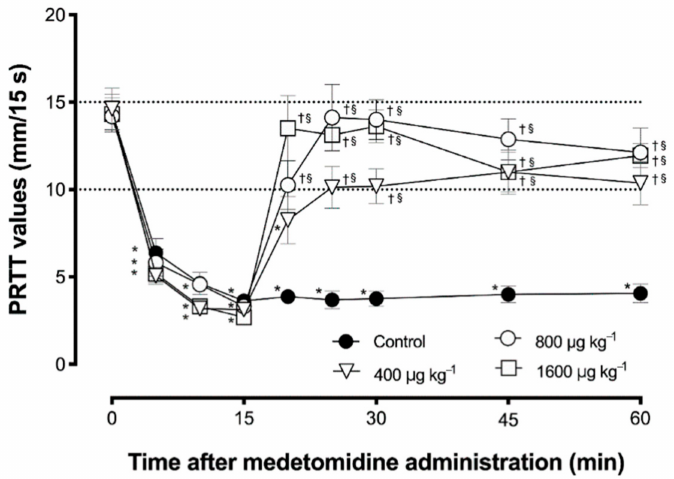
Figure 1. The mean ± standard error of the mean of phenol red thread test (PRTT) values before and after intramuscular administration of medetomidine ( n = 8). Statistical di ff erences with significance ( p < 0.01) compared with (*) the baseline value within the group, ( † ) the value at each time point in the control group, and (§) the value at 15 min after medetomidine administration within the